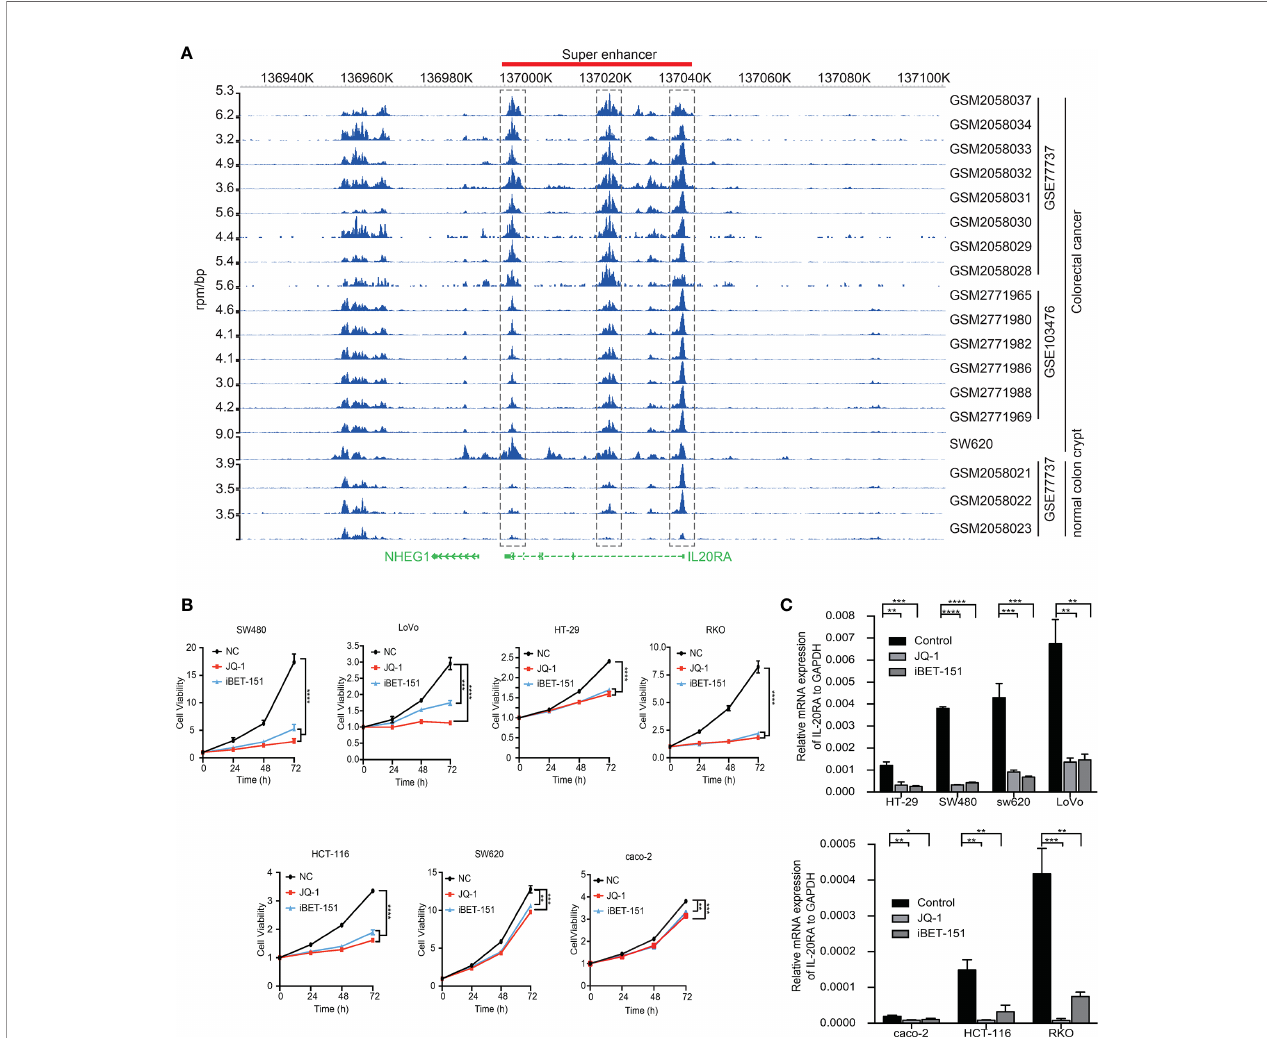
FIGURE 2 | IL-20RA was activated by super-enhancers in colorectal cancer. (A) Genome-browser screenshot showing the binding of H3K27ac to the regulatory region of IL-20RA in primary CRC tumor cells, cell lines and normal colon tissues. (B) Super-enhancer inhibition decreased the cell growth of colorectal cancer cell lines. The viabilities of RKO, HT-29, and LoVo cells were detected after 0, 24, 48, and 72 hours of JQ-1 or i-BET treatment. (C) Super-enhancer inhibition decreased the expression of IL-20RA in CRC cells. The expression of IL-20RA was examined in RKO, HT-29, and LoVo cells after 48 hours of JQ-1 or i-BET treatment. *P < 0.05, **P < 0.01, ***P < 0.001, ****P <